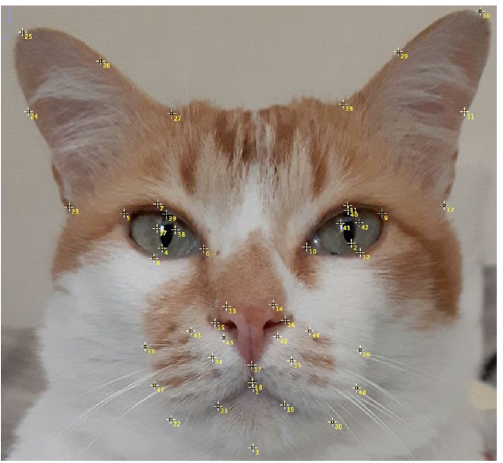
Figure 1. Mirror image of cat’s face, depicting placement of the 48 facial landmarks. Landmarks appear contralateral to their origin, as they would when directly observing the cat’s face.